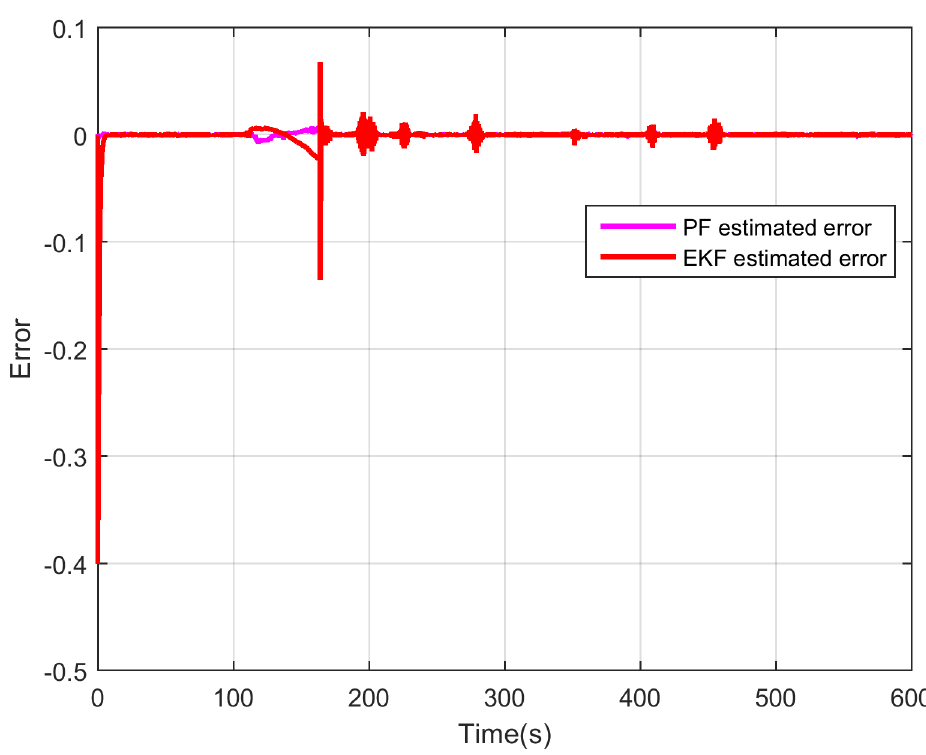
Fig 9. Errors of model predicted ammonia coverage ratio and PF estimated ammonia coverage